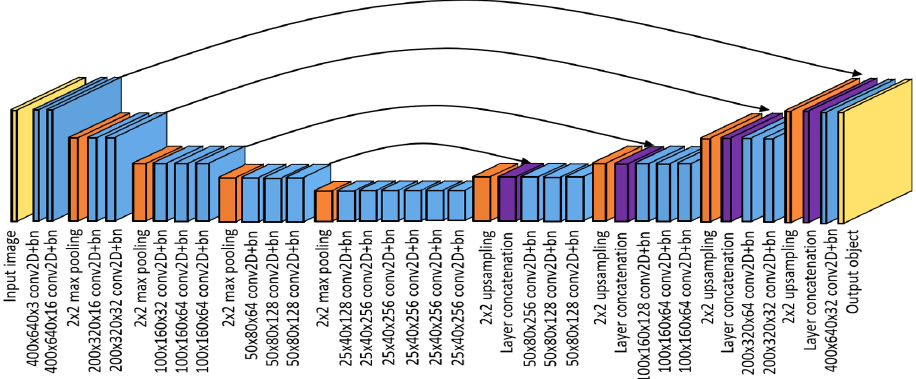
Figure 4. The implemented CNN follows an autoencoder structure to create the seven-channel output object given a gray-scaled video frame. For each convolutional layer the dimensional information is given in the format height × width × number of convolutional